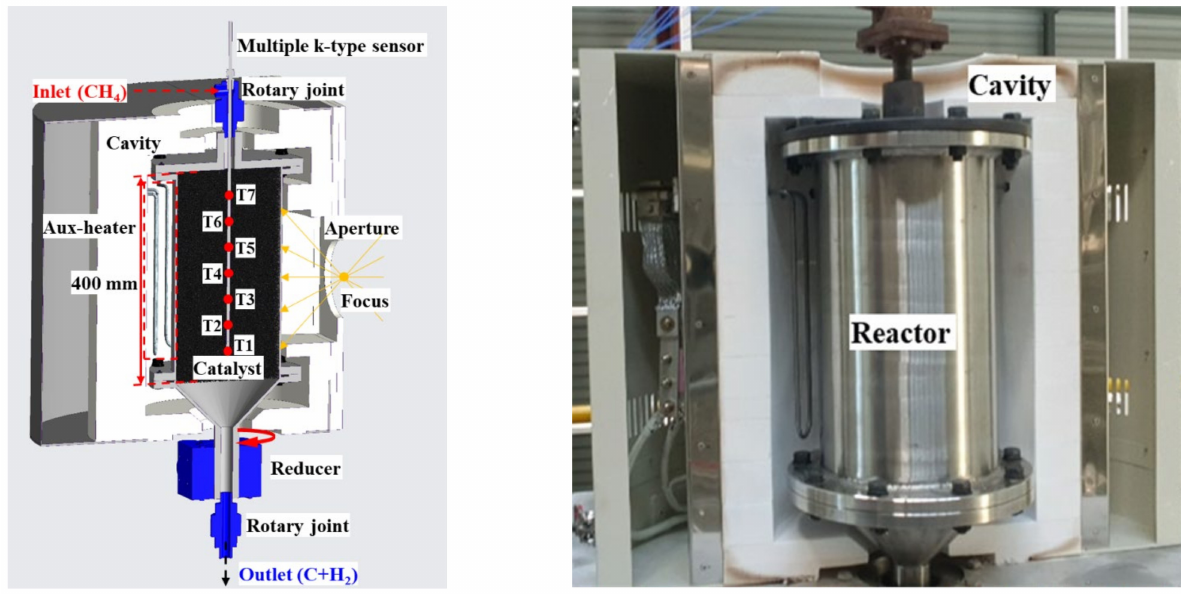
Figure 10. Rotary cylindrical reactor 2 & cavity